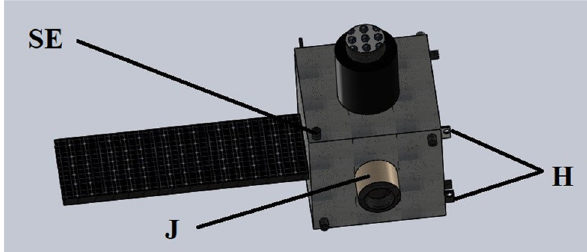
Figure 3: Bottom view of the micro/nanosatellite. H: hook system for the removal net and node satellite; SE: small - thrust engine; and J: joint connection mechanism ( functions as a connection under normal states and transforms into a large - thrust engine when removing ) .